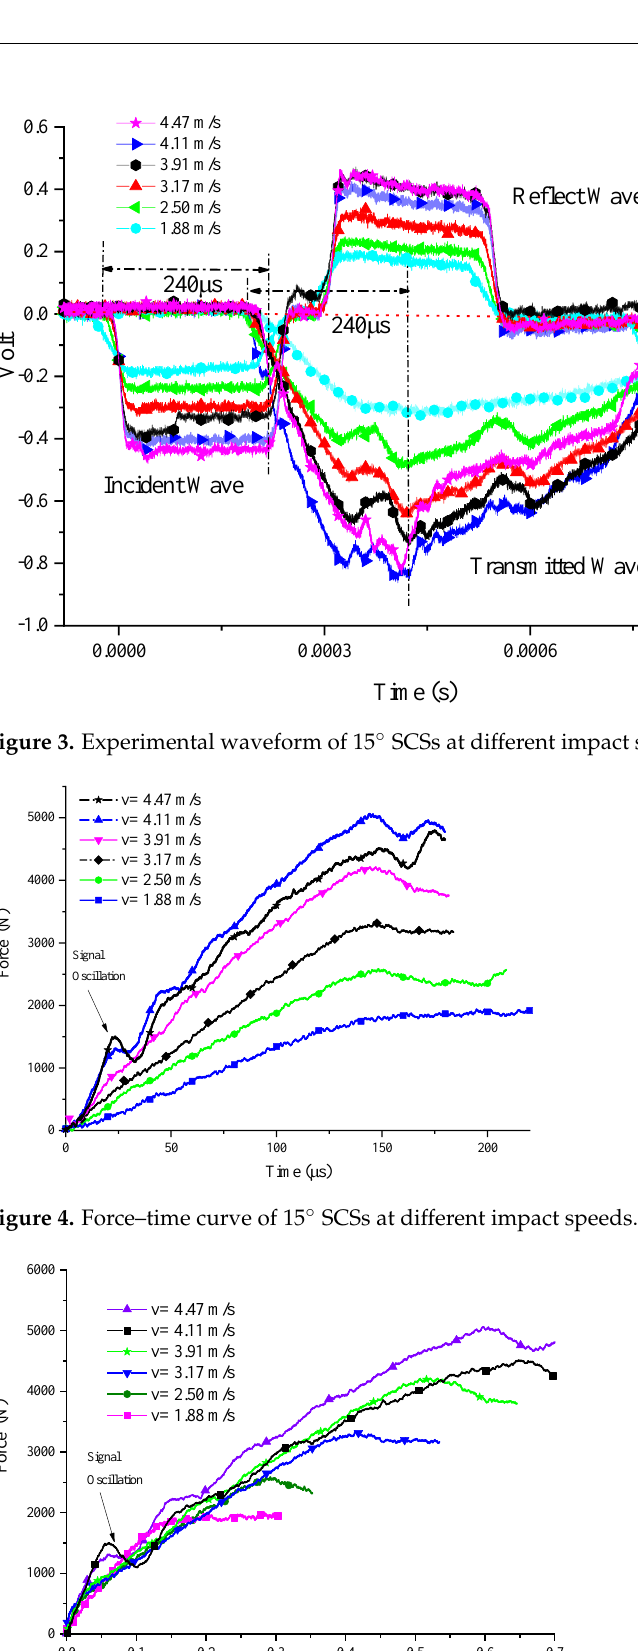
Compression Strain % Figure 6. Normal stress–strain of 15° SCSs at different impact speeds. 0 Shear Strain % Figure 7. Shear stress–strain of 15° SCSs at different impact speeds. The yield loads at different impact velocities and the displacements corresponding to the loads were obtained according to Figure 5, while the normal and tangential yield stress components were worked out according to Figures 6 and 7, respectively. In the case that the specimen was damaged, as shown by the experimental results when the impact